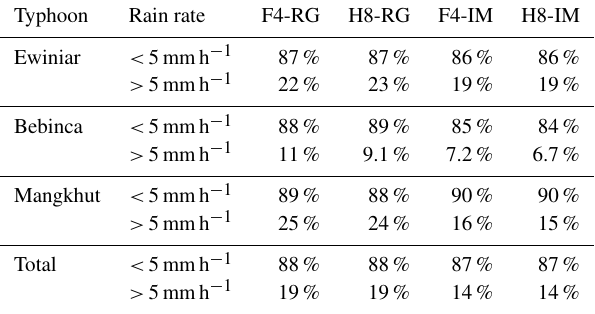
Table 5. Surface precipitation overestimation percentages for the four models during the three typhoons.